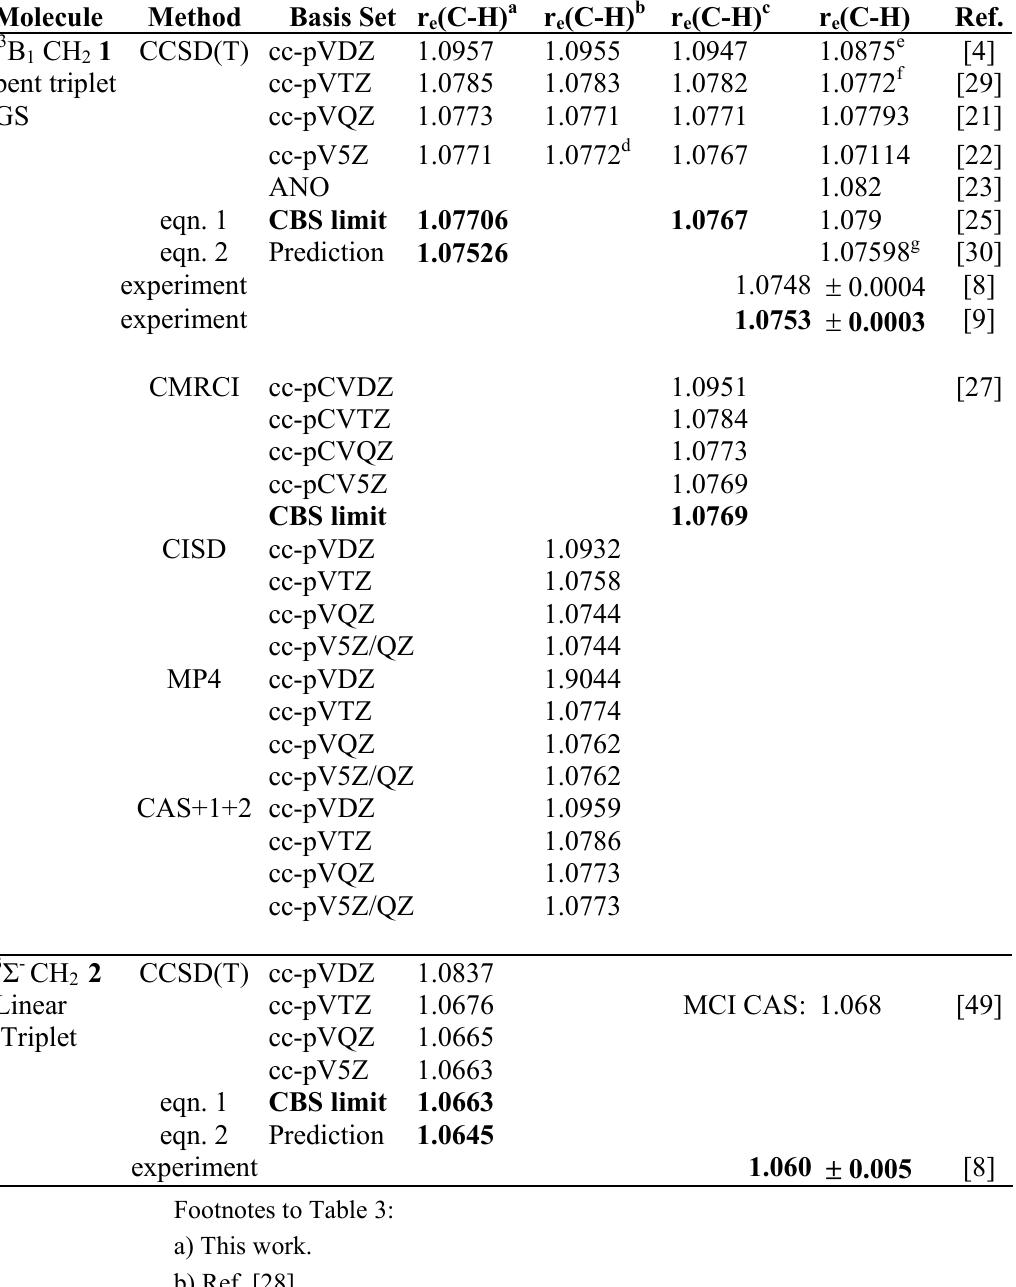
Table 3. Frozen-core by CCSD(T) and other post-HF methods calculated equilibrium (C-H) [Å] of triplet methylenes 1 and 2 in comparison to experimental and distances r e literature